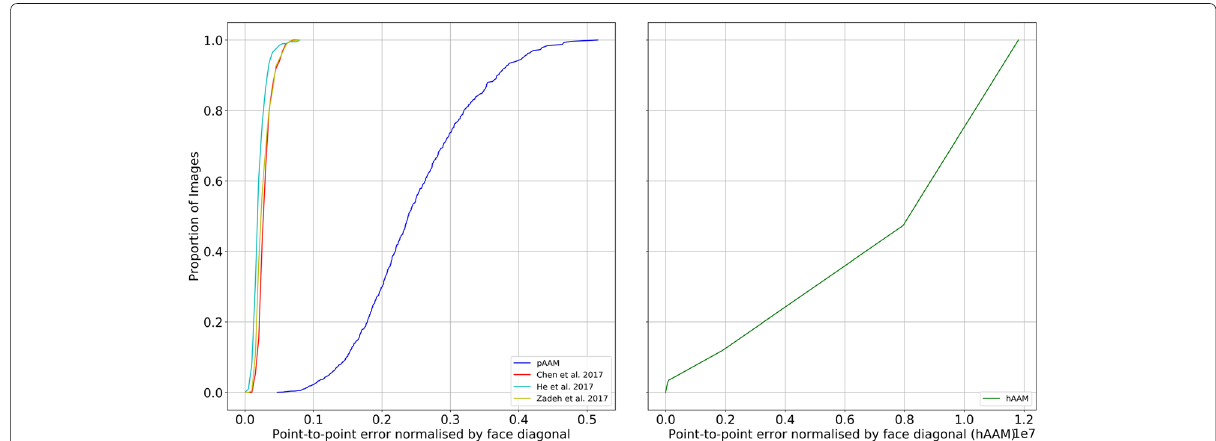
Fig. 18 Menpo (profile) cumulative error distributions. Comparing the performance of holistic AAMs, patch AAMs, and the performance reported by Chen et al. [63], He et al. [67], and Zadeh et al.